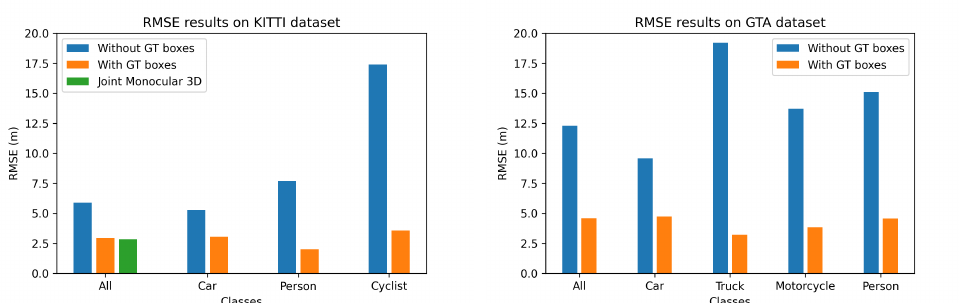
Figure 4. In these graphs, we compare the depth RMSE obtained by our method (with or without ground truth box) on the different dataset classes; we also include the results of the “3D joint monocular” method (which also uses ground truth boxes). We can see that our method obtains a higher RMSE error when we do not use GT bounding boxes. This can be explained by the fact that the boxes used for feature alignment during inference are the same as those used during training. We can also see that there is a significant loss in accuracy on smaller classes such as bicycles or people when our method predicts RoIs using YOLOv3 instead of using ground truth. This can be explained by the fact that variations in the prediction of RoIs have a greater impact than for larger classes like